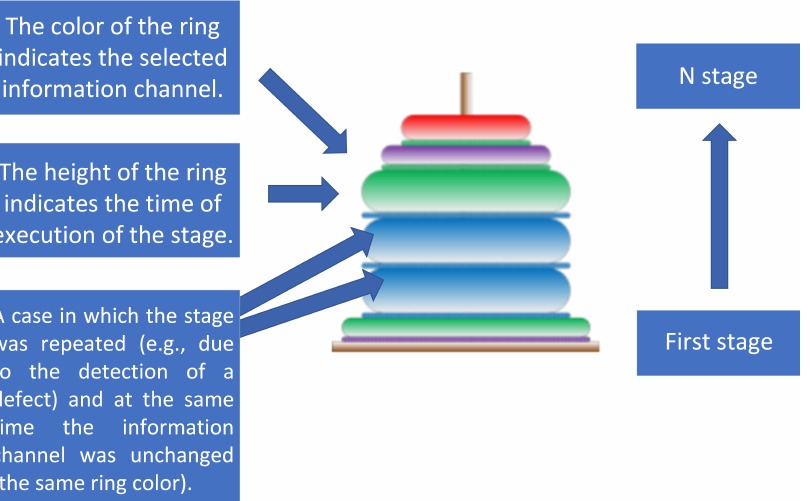
Figure 2. Graphic explanation of the idea of reflecting the process as an analogy to the towers of Hanoi presented in